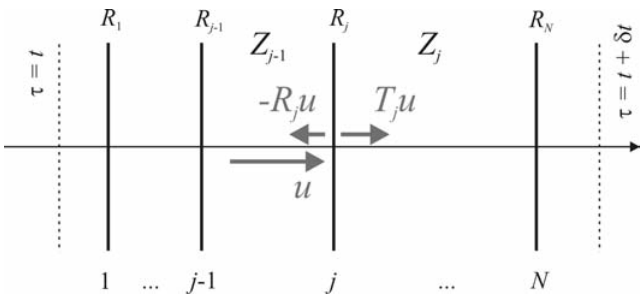
Figure 4. One-dimensional plane-wave reflection-transmission problem. Solid lines are reflectors, dashed lines are incident-wave wavefronts at times t and t + d t . Multiple reflections have been